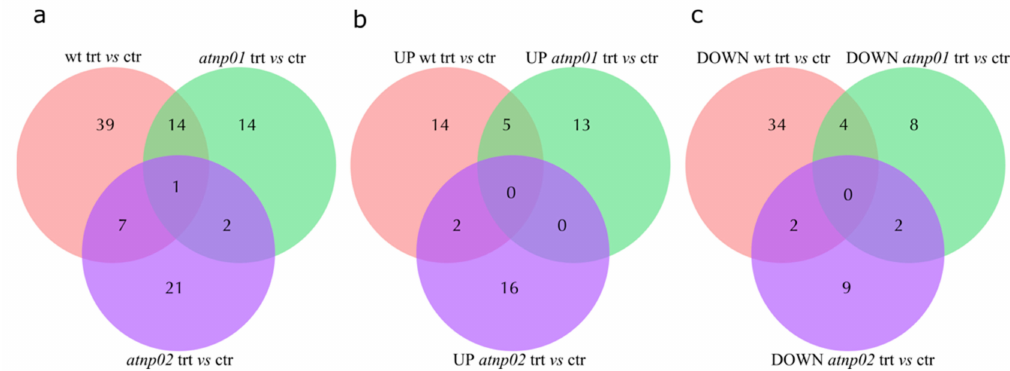
Figure 1. Venn diagrams showing proteins common and non-common to wt and atnp01 , to wt and atnp02 , to atnp01 and atnp02 and to all treatment conditions. ( a ) There were 15 proteins common between wt and atnp01 , 8 between wt and atnp02 , and 3 between the two mutants; ( b ) The proteins upregulated in wt, atnp01 and atnp02 lines between control and treatment conditions. There were four upregulated proteins in common between wt and atnp01 , two between wt and atnp02 , and none between the two mutants; ( c ) The proteins downregulated in wt, atnp01 and atnp02 mutant lines between control and treatment conditions. There were four downregulated proteins in common between wt and atnp01 , two between wt and atnp02 , and two between the two